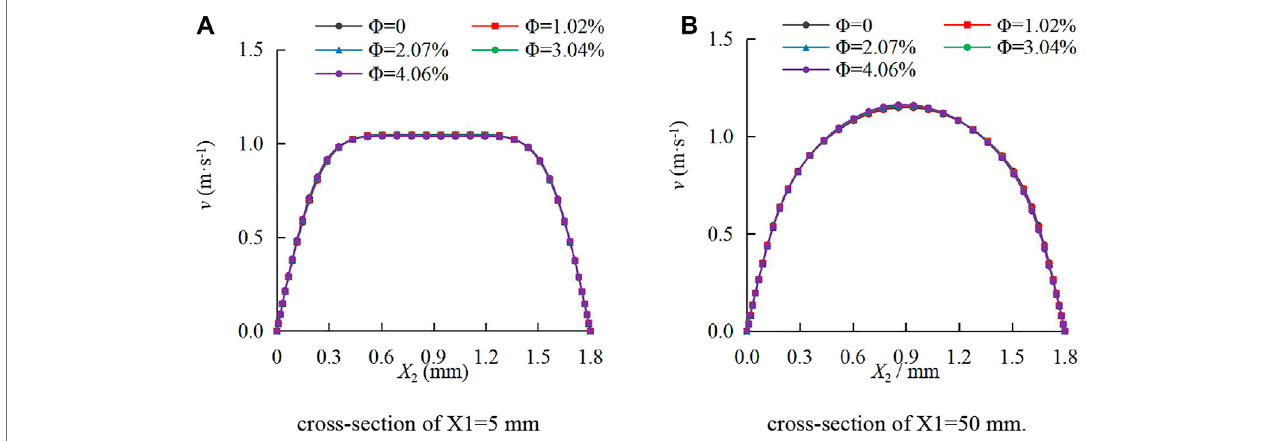
FIGURE 7 | Mean velocity distributions of the continuous-phase fl uid on smooth fracture sections under different sediment volume concentrations. (A) Cross section of X1=5 mm; (B) cross section of X1=50 mm.